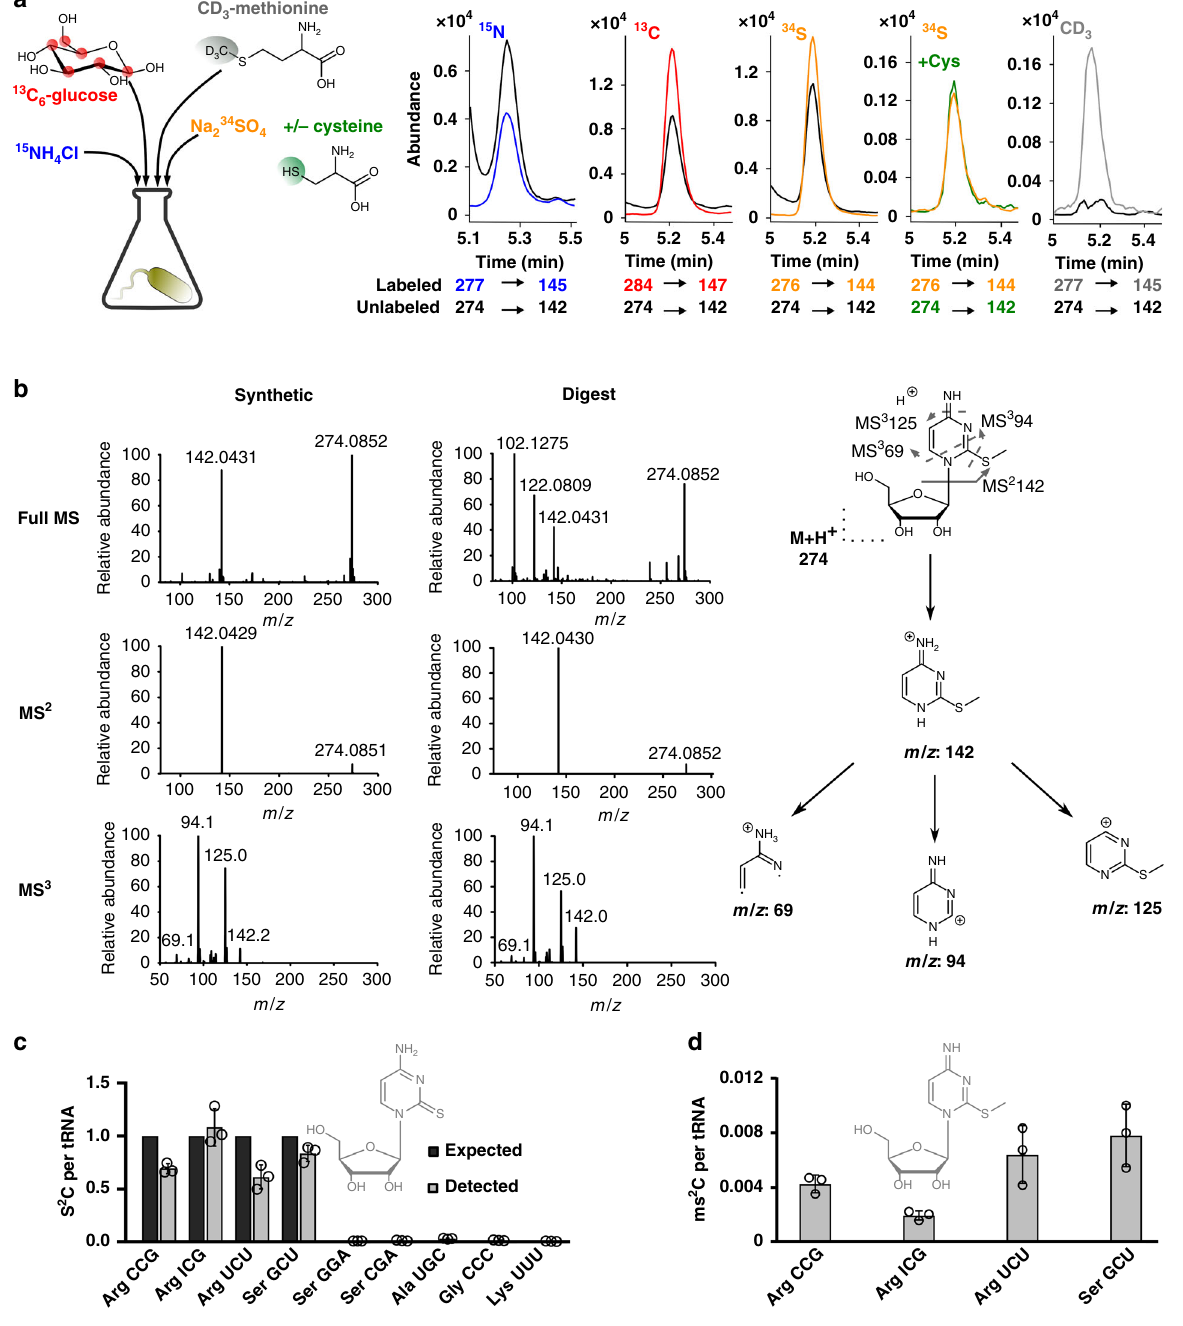
Fig. 1 Veri fi cation of 2-methylthiocytidine (ms 2 C) structure and distribution in bacterial tRNA isoacceptors. a Different isotope labeling in bacteria. Co- elution of the synthesized ms 2 C nucleoside (black) and ms 2 C from [ 15 N], [ 13 C] or [ 34 S] labeled bacteria and products of metabolic labeling with [ 32 S]- cysteine in [ 34 S] medium and CD 3 -methionine labeling. The respective isotope is indicated above each chromatogram. b High resolution mass spectrometry and fragmentation of ms 2 C by direct injection of the synthetic standard or the natural bacterial digest and collision induced dissociation. c Expected (black) 1 and experimentally detected (gray) abundance of s 2 C per respective tRNA isoacceptor. d Experimentally detected abundance of ms 2 C per respective s 2 C containing tRNA isoacceptor. All experiments are from n = 3 biol. replicates, error bars re fl ect standard deviation. Source data of ( c ) and ( d ) are provided as a Source Data fi